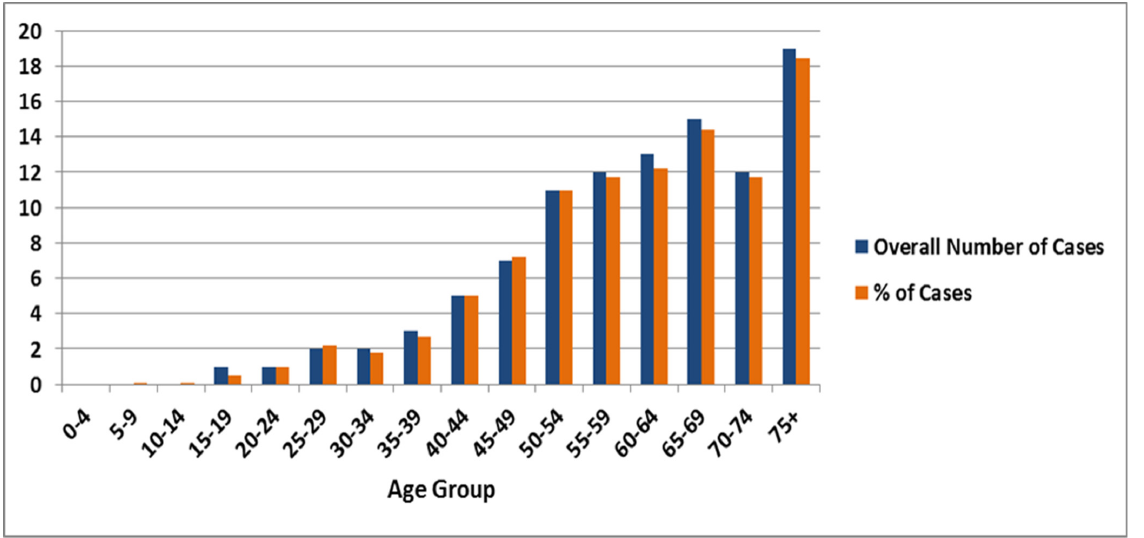
Figure 2. Graphical representation of number and percentage of lung cancer in females between 2006 and 2016.